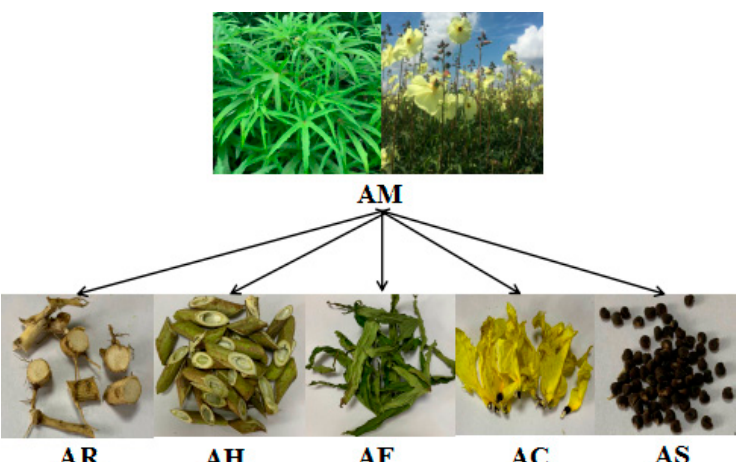
Figure 5. Five segments (AR, AH, AF, AC, and AS) of AM.